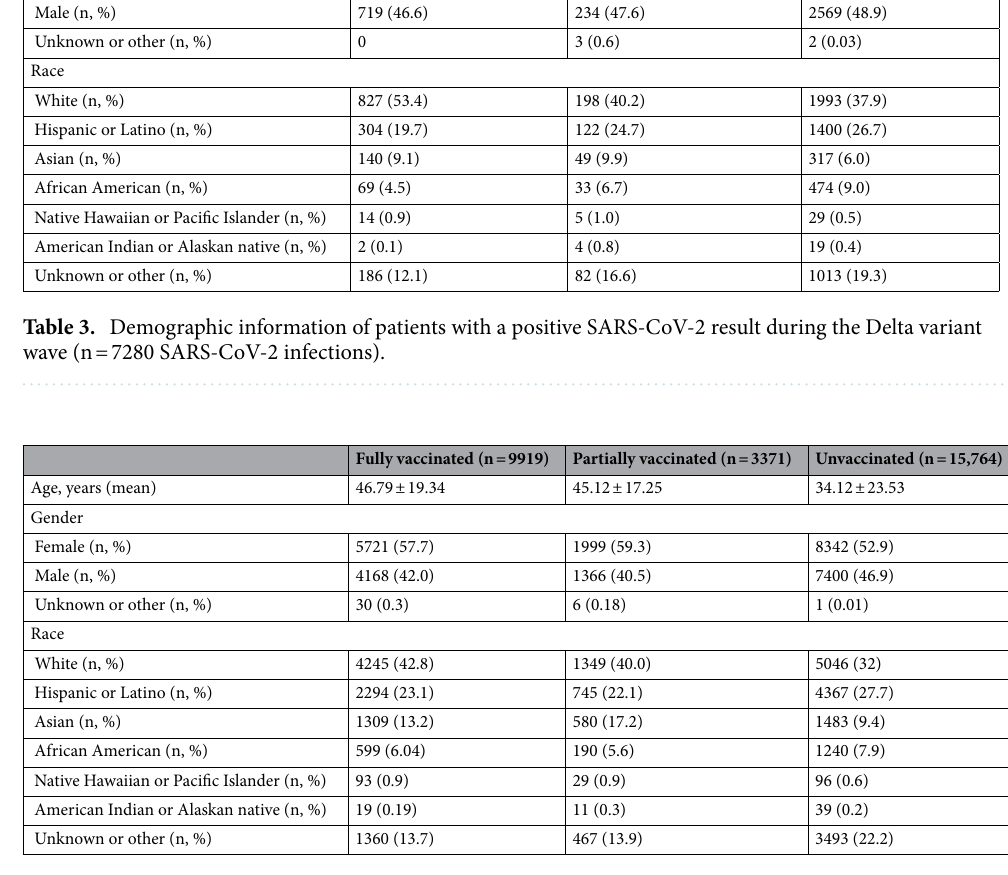
Table 4. Demographic information of patients with a positive SARS-CoV-2 result during the Omicron variant wave (n = 29,054 SARS-CoV-2